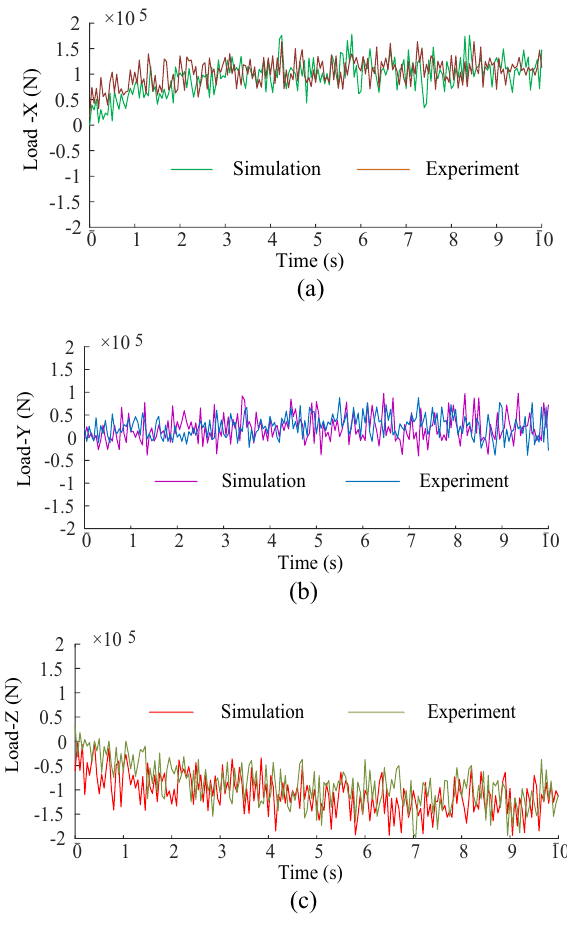
Figure 13. The comparison curves between experimental force and simulation result: ( a ) X-direction; ( b ) Y-direction; ( c )